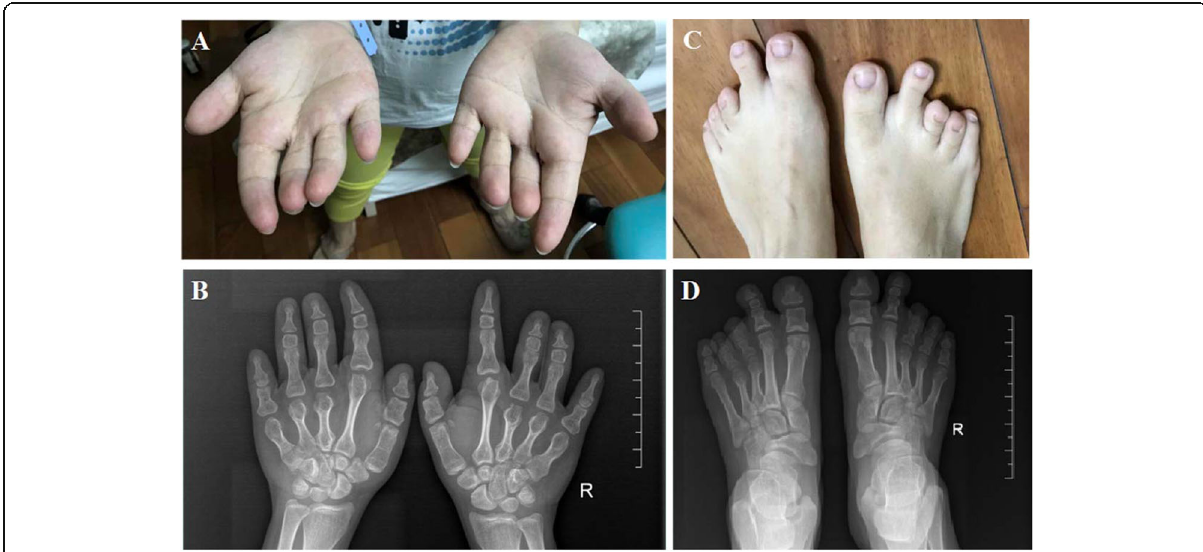
Fig. 2 a – d The appearance and radiological findings of the proband with brachydactyly type A1(BDA1). a showing shortened fingers and absence of middle phalanges of the fifth finger and radial deviation of the second finger. b Radiographic images of proband ’ s hand: shortening of the middle phalanges of digits II – V, fusion of middle and terminal phalanges of 5th finger, bilateral shortening of metacarpals bone 3 – 5. c showing short toes and absence of middle phalanges of the third to fifth toes. d Radiographic images of proband ’ s foot: fusion of middle and terminal phalanges of third to fifth toe, bilateral shortening of metatarsals bone 3 –